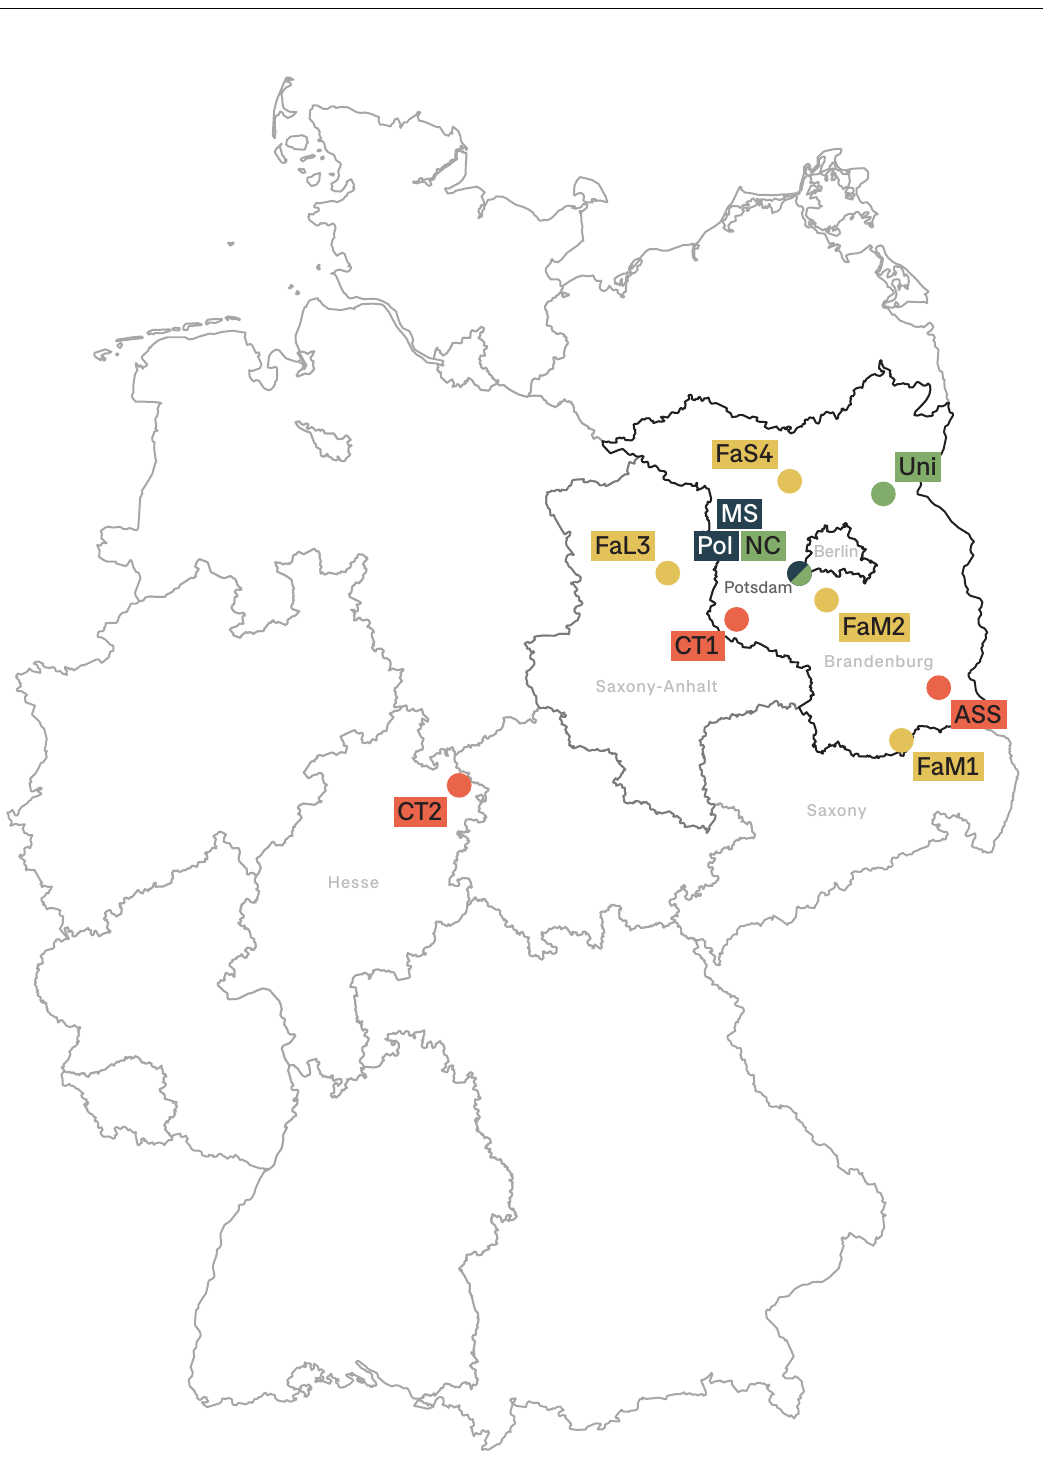
Figure 1. Location of the key actors interviewed on a map of Germany with Uni = Eberswalde University for Sustainable Development, FaS4 = small-sized farm, FaL3 = large-sized farm, FaM2 = medium-sized farm2, FaM1 = medium-sized farm1, Pol = politician, NC = nature conservation organization, MS = state ministry, CT2 = consultant2, CT1 = consultant1, ASS = German association for